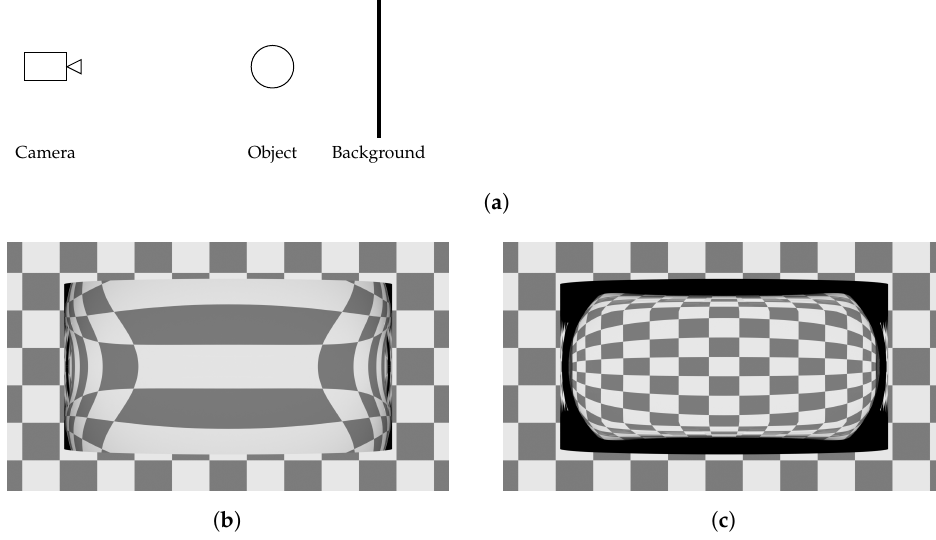
Figure 5. The effect of light refraction. ( a ) Setup, ( b ) a cylinder filled with water (IOR = 1.333), versus ( c ) a cylinder filled with air in a water domain (IOR =